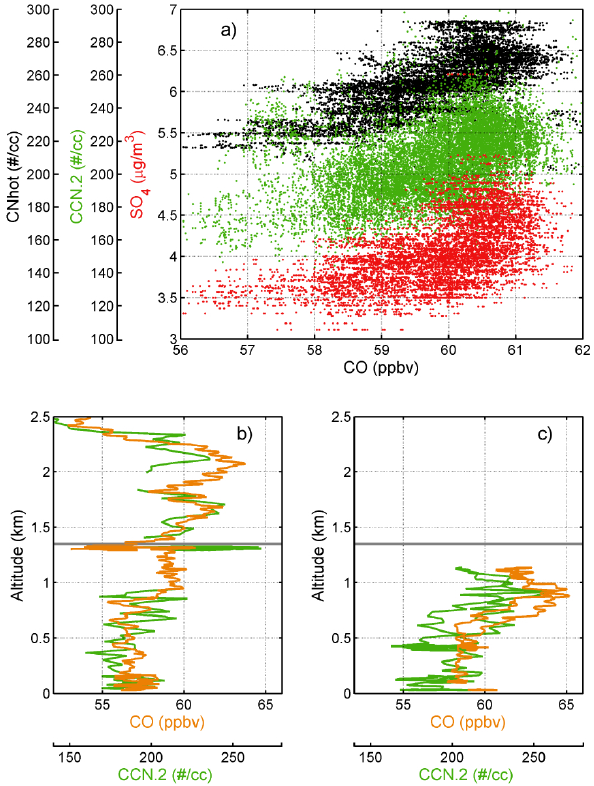
Fig. 12. (a) Trends in CNhot, CCN.2, and AMS sulfate vs. CO for level MBL legs during RF05; (b, c) profiles of CO and CCN.2 for